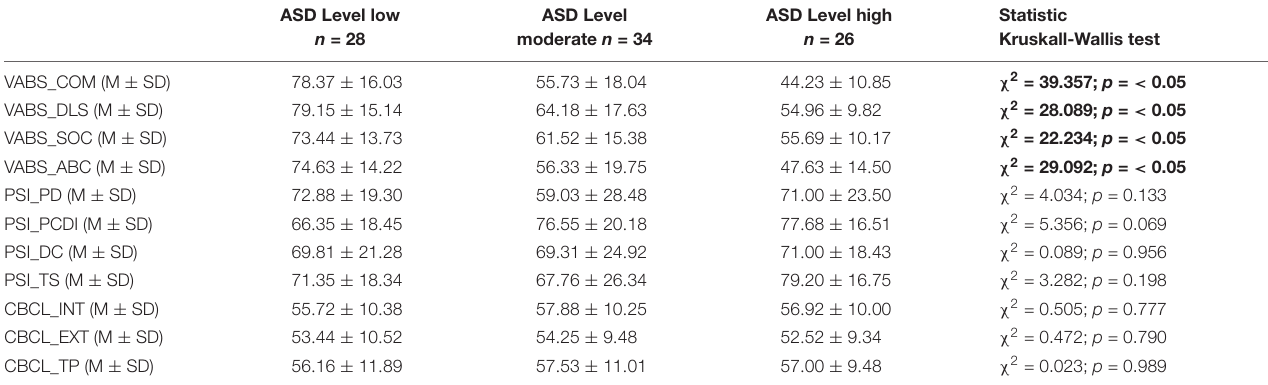
TABLE 2 | Mean scores comparison among the three ASD severity levels.